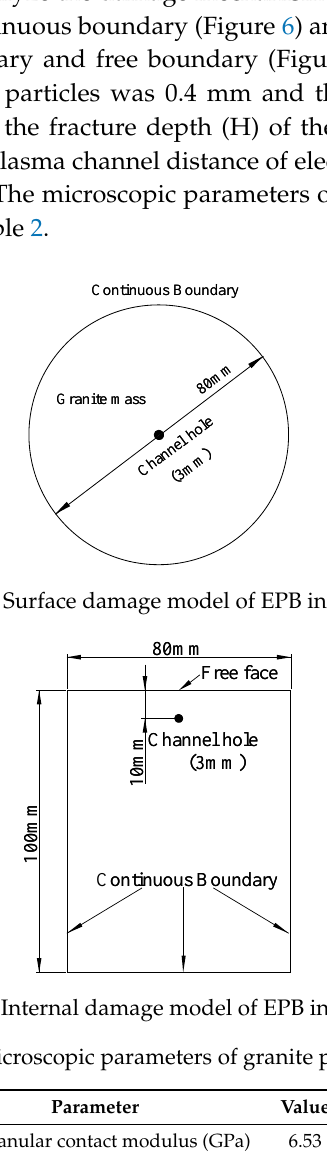
Table 2 . The microscopic parameters of granite particle model.